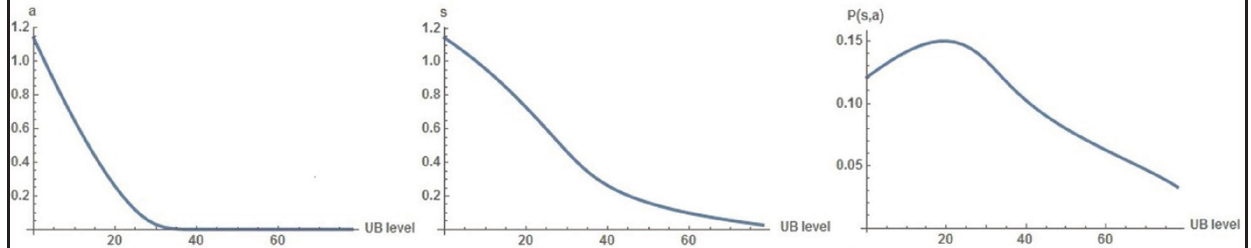
Finite Entitlement [FE]. The three graphs show the level of a the unemployment spell, in the model [FE] for different values of b . The functions and parameters are those of Table 1, except for f , which is now equal to zero. We set T = 200, the total quantity of time, and B = 100, the number of periods in which the agent is entitled to the flat benefit b